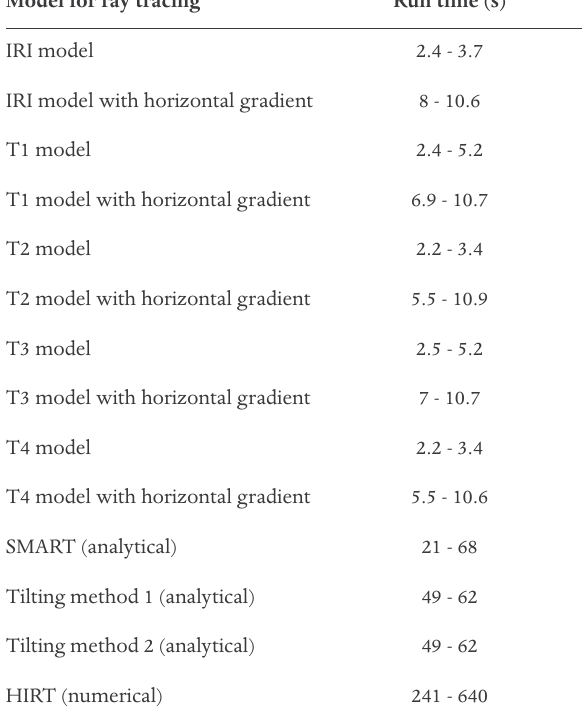
Table 3. Performance analysis of different tomographic model and comparison with existing analytical and numerical models.